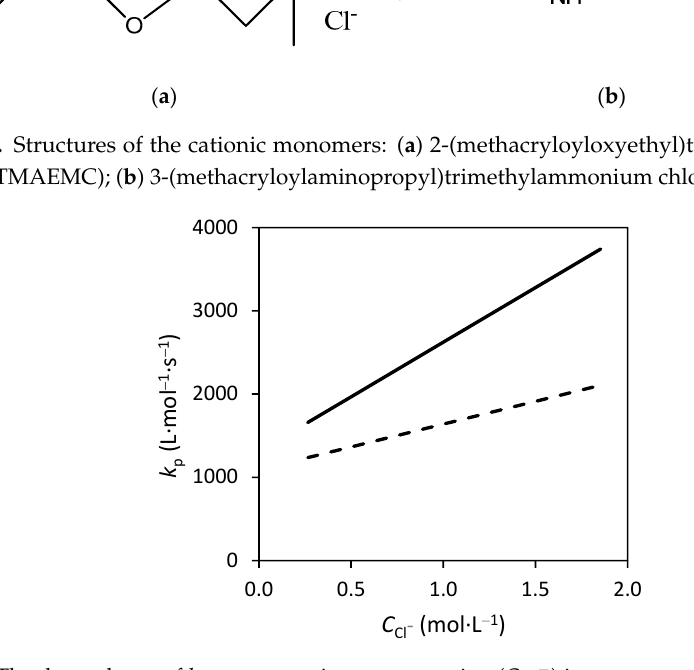
Figure 1. The dependence of k p on counterion concentration ( C Cl − ) in aqueous solution for TMAEMC ( ⎯ ) and MAPTAC (- - -) at 50 °C, as generated using representations developed for TMAEMC [27] and MAPTAC (this work) based on PLP-SEC experimentation [26].